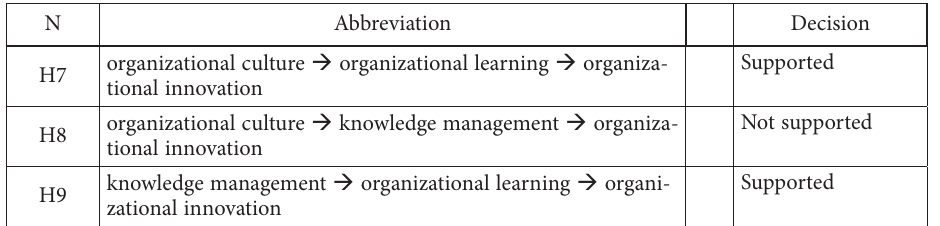
Table 10. Summary of mediation